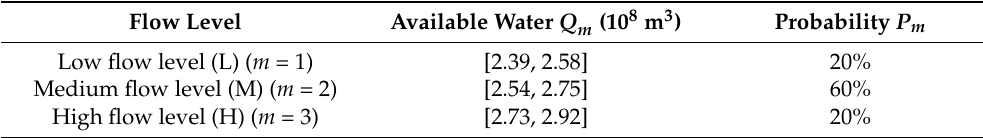
Table 3. Available water under different flow